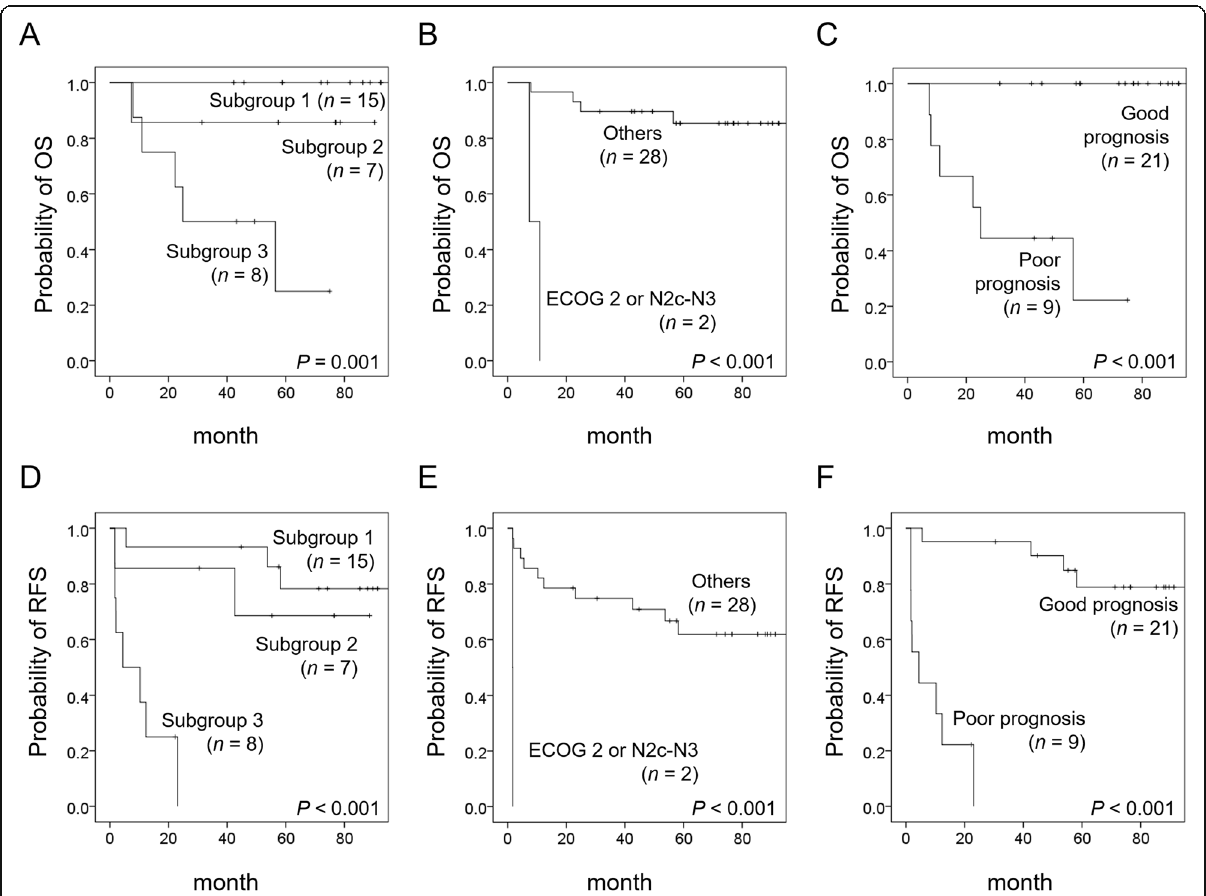
Fig. 3 Kaplan-Meier plots of different survival endpoints according to PET risk patterns ( a , overall survival; d , relapse-free survival), N2c-N3 stage or poor performance status ( b , overall survival; e , relapse-free survival), and prognostic model ( c , overall survival; f , relapse-free survival) in the validation